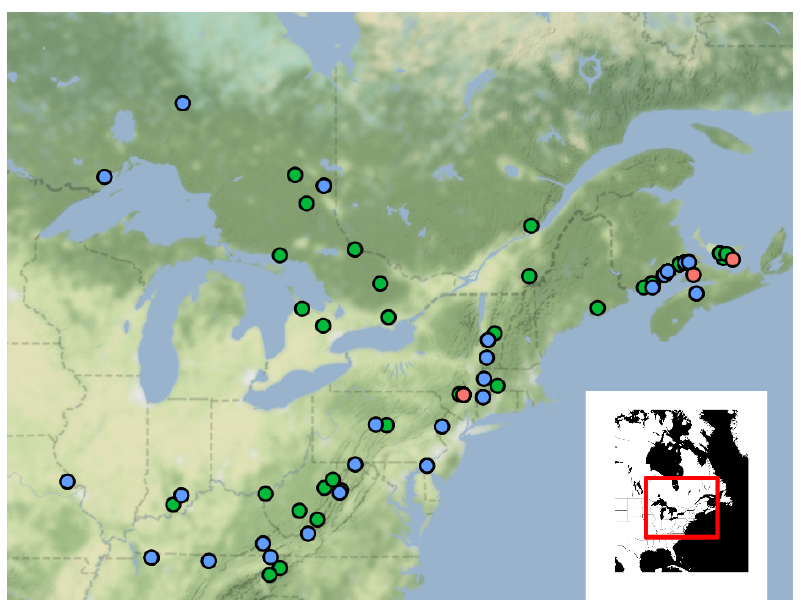
Figure 1. Map of sampling locations from across North America, with each point representing one of more isolate(s) genotyped using whole genome SNPs (blue), multiple microsatellite loci (green), or a combination of both (red). Many of the isolates used here are the result of genotyping in previous studies (See Table S1).